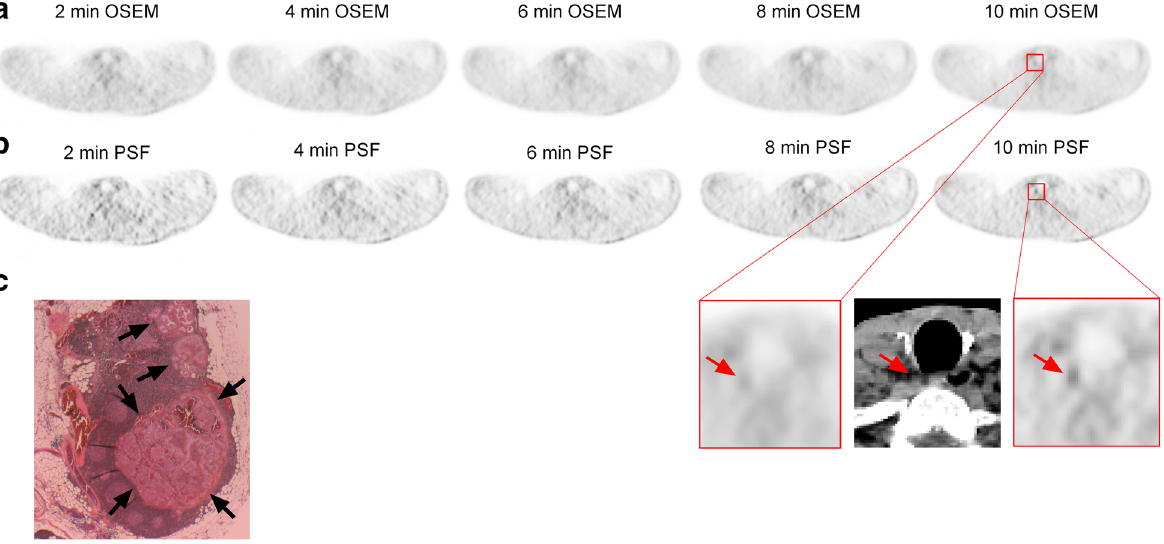
Fig. 5 A 40-year-old male patient with a 20-mm papillary DTC was referred for 18 FDG PET/CT in November 2015. He had previously undergone total thyroidectomy in 2001 and remission was observed during yearly follow-up until 2014. In 2015, the serum Tg was still < 0.04 ng/ml but serum TgAb appeared. Head-and-neck PET was performed. Axial PET on the same level was shown with 3D-OSEM ( a ) and PSF allpass ( b ) reconstructions. No abnormal 18 FDG focus was reported on 3D-OSEM-reconstructed HN PET (at 10 min: SUVmax = 1.44, TBR = 0.99). On the PSF allpass -reconstructed HN PET data sets, a faint focal 18 FDG uptake in the right-sided central compartment was scored as probably malignant (score 4) at 10 min (SUVmax = 2.26, TBR = 1.46), corresponding to a 5 × 3 mm lymph node on CT scan (red arrows). c Pathology confirmed that this abnormal focus was truly malignant. The size of the tumour deposit in the right central lymph node was 5 mm (HES staining, × 2.5; black